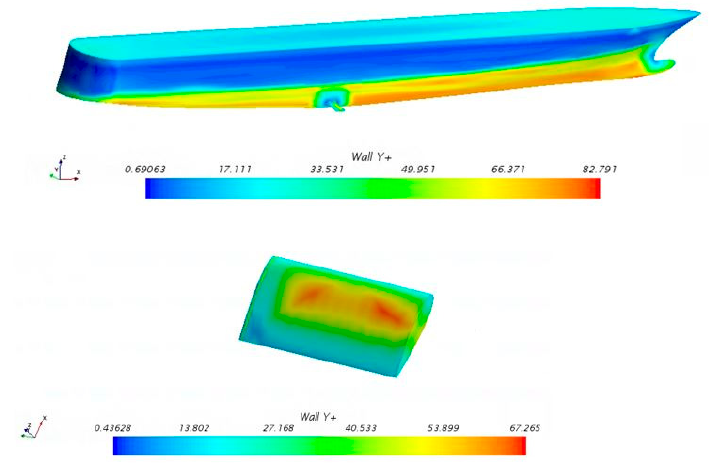
Figure 8. Y+ distribution.